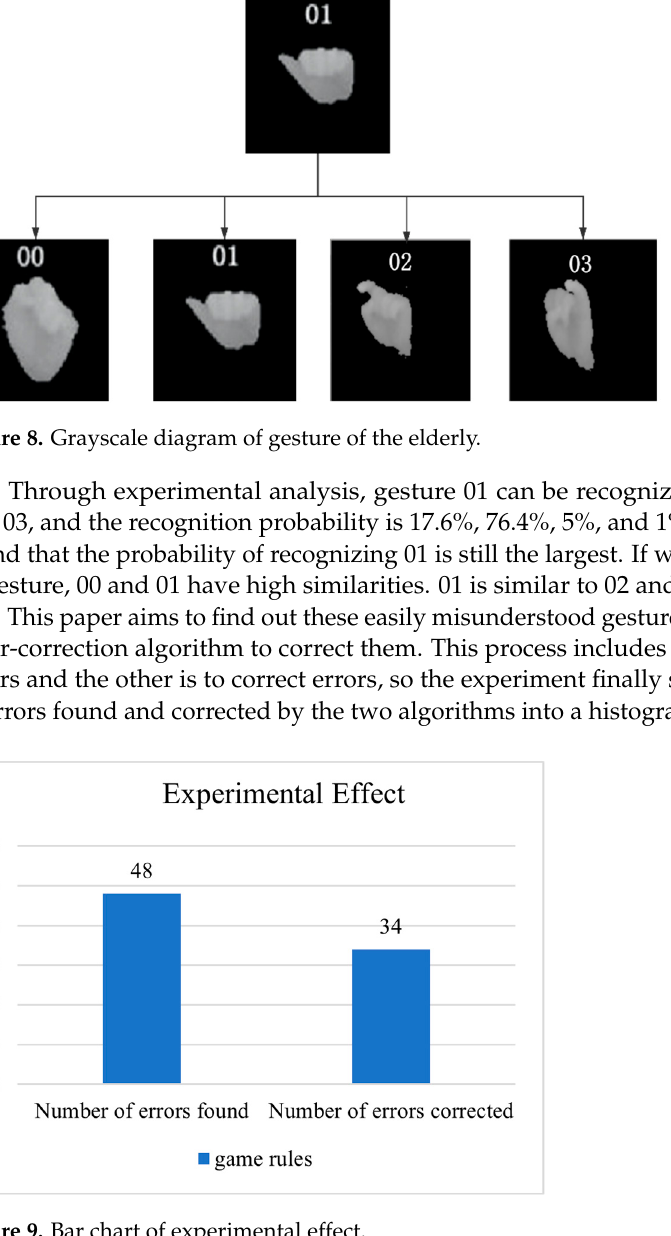
Figure 9. Bar chart of experimental